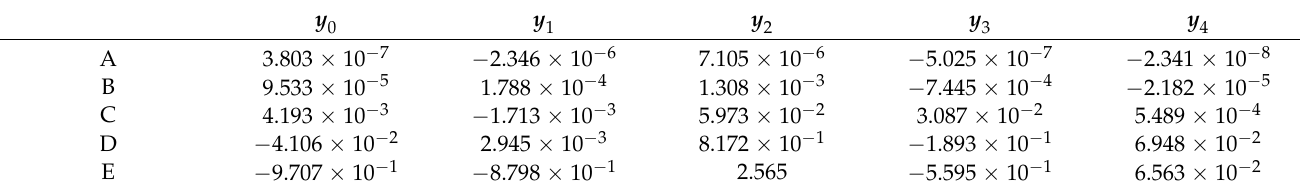
Table 1. Polynomial fitting coefficient table.